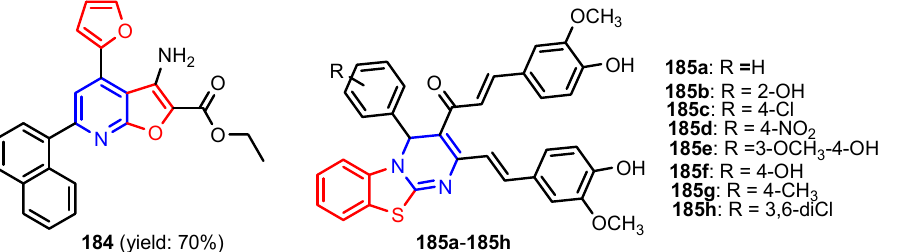
Scheme 40. Synthesis of pyridoquinolone 183a − 183b [77].